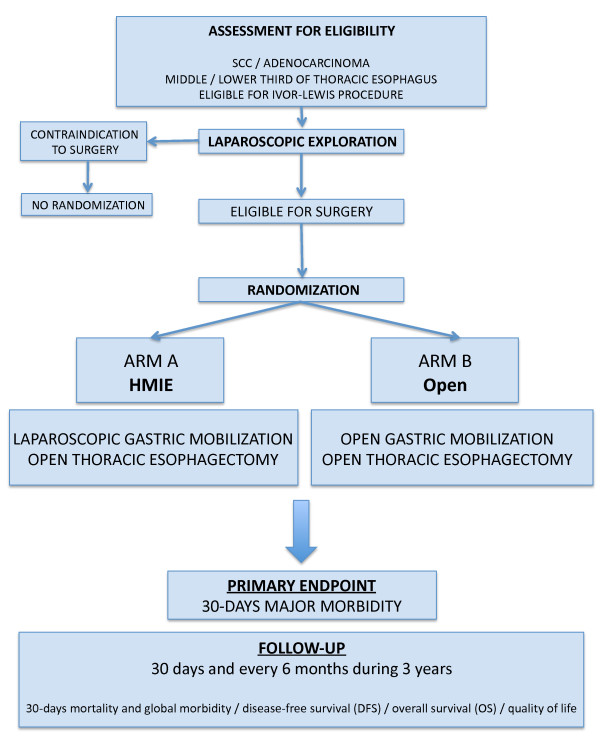
Study flow chart.